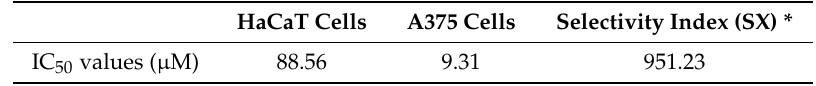
Table 1. The half-maximal inhibitory concentration (IC 50 ) values of the peptide ∆ M4 on non-tumoral HaCaT cells and melanoma A375 skin cells, and the corresponding selectivity index (SX).